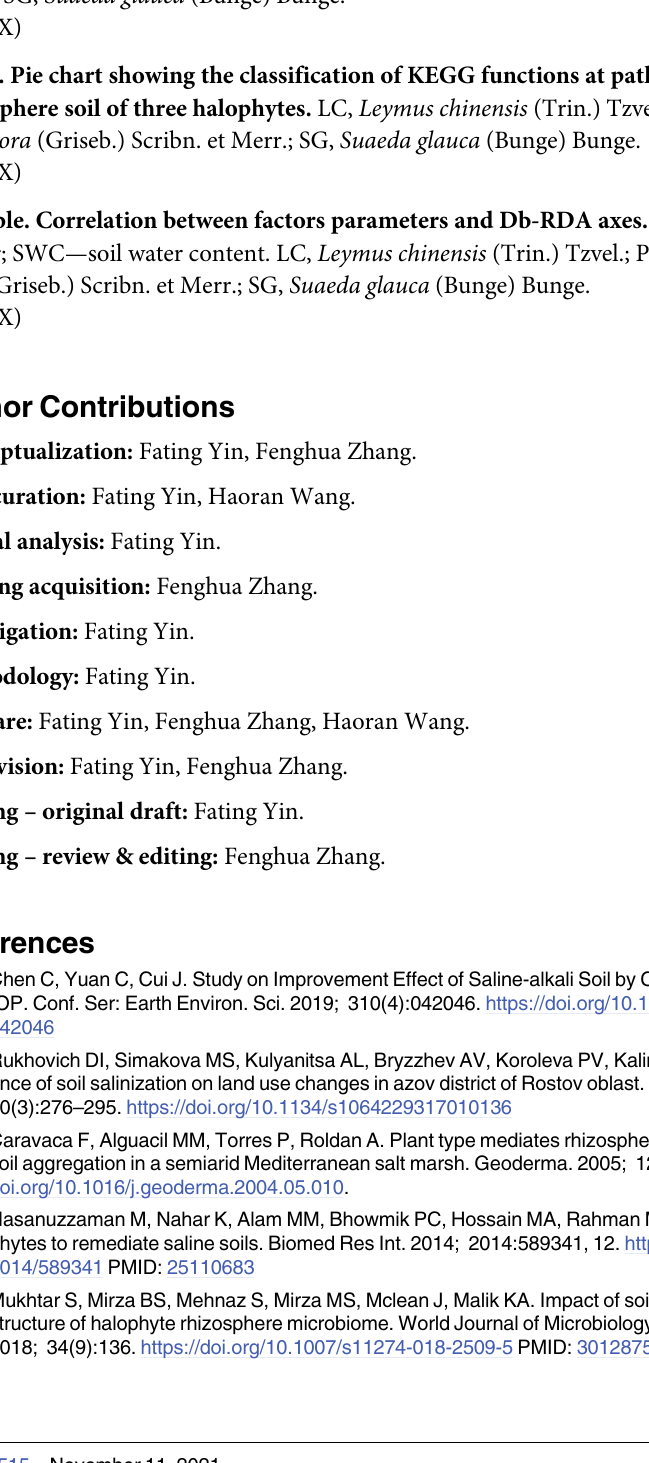
S2 Fig. Venn diagram showing unique and shared OTUs under rhizosphere soil of three halophytes. LC, Leymus chinensis (Trin.) Tzvel.; PT, Puccinellia tenuiflora (Griseb.) Scribn. et Merr.; SG, Suaeda glauca (Bunge) Bunge. S3 Fig. Pie chart showing the classification of KEGG functions at pathway Level1 under rhizosphere soil of three halophytes. LC, Leymus chinensis (Trin.) Tzvel.; PT, Puccinellia tenuiflora (Griseb.) Scribn. et Merr.; SG, Suaeda glauca (Bunge) Bunge. (DOCX) S1 Table. Correlation between factors parameters and Db-RDA axes. SOM—soil organic matter; SWC—soil water content. LC, Leymus chinensis (Trin.) Tzvel.; PT, Puccinellia tenui- flora (Griseb.) Scribn. et Merr.; SG, Suaeda glauca (Bunge)